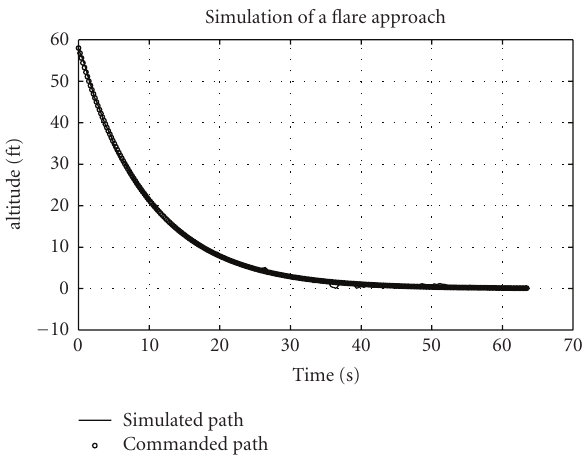
Figure 6: Longitudinal dynamics—feed-back with Kalman filter.